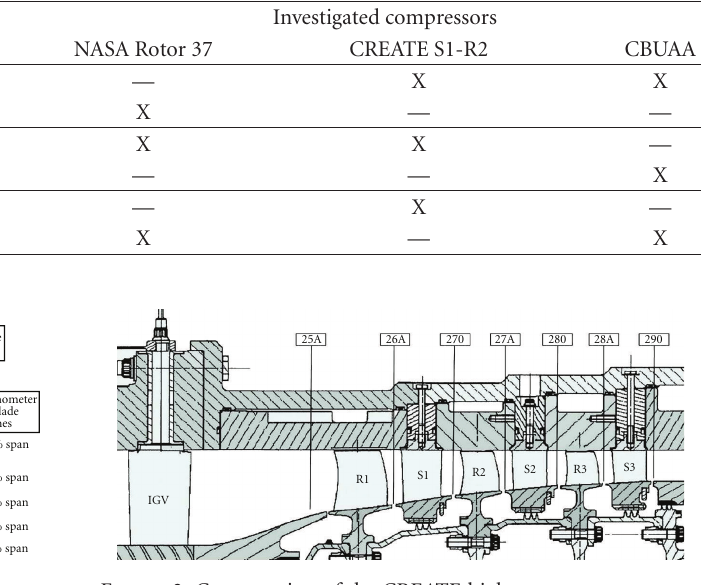
Figure 2: Cross-section of the CREATE high-pressure compressor and measurement planes. Table 3: Design features of CREATE. Table 4: Number of blades of CREATE